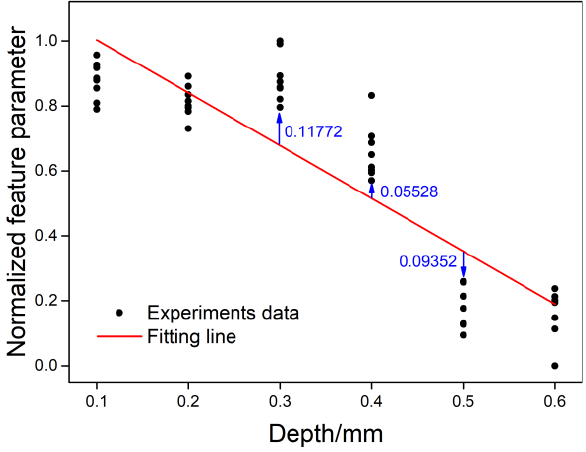
Figure 25. Experimental data and fitting line of the normalized feature parameter versus depth.